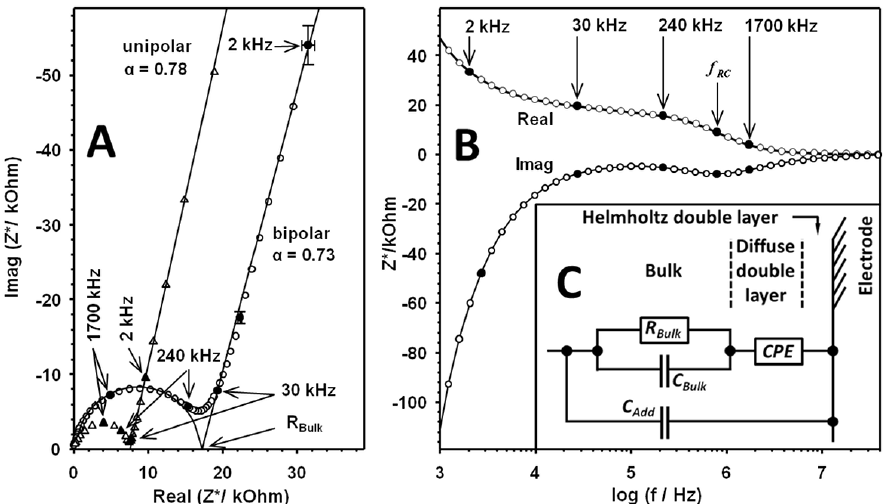
Figure 2: Illustration of the impedance Z* of unipolar and bipolar electrodes measured in the calibration solution. For clarity, not all 401 measuring points per spectrum were plotted, and error bars are only provided as examples. Above 30 kHz, all error bars were smaller than the size of the measuring point symbols. (A) Complex plots illustrate the fitting procedure for R Bulk using a straight line and a semicircle. For α, see equation (1). The plots indicate that CPE effects are pronounced in a wider frequency range in the spectrum of the bipolar electrode compared with the unipolar electrode. Measuring points for 2, 30, 240, and 1700 kHz are filled. (B) Plot of the real and imaginary parts of the impedance of the bipolar electrode over the frequency. In (A), the characteristic frequency f RC is located above the center of the semicircle. (C) Equivalent circuit of the electrode impedance and its surrounding medium. R Bulk and C Bulk describe the properties of the bulk medium in contact with the bared electrode contacts. C add summarizes additional capacitances in the measuring setup. The CPE describes the impedance of the electrode effects at the metal-medium interface. For the calibration solution, R Bulk = R Cal